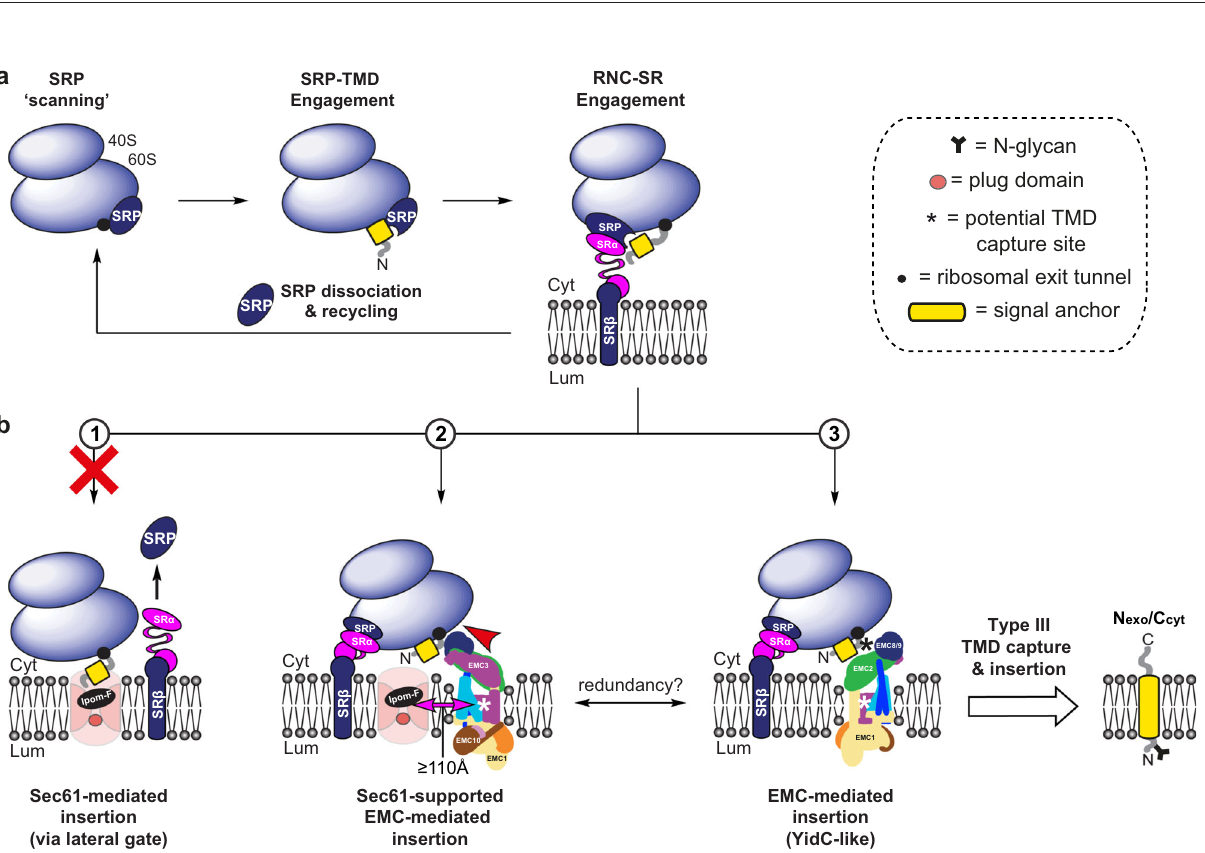
Fig. 6 Type III TMP insertion is dependent on the SRP receptor. a A model of SRP-dependent targeting to the ER membrane: the SRP ‘ scans ’ the emerging nascent chain of a translating ribosome for hydrophobic ER signal-sequences or transmembrane domains, binds the ribosome-nascent chain complex and delivers it to the ER membrane via its interaction with the SRP receptor, prior to membrane insertion 43 . The SRP receptor is a heterodimer comprised of the ER membrane-integrated beta subunit (SR β ) anchoring the peripherally associated cytosolic alpha subunit (SR α ). b The effect of transfecting HeLa cells with non-targeting (NT; lane 1), SR α -targeting (lane 2), SR α + EMC5-targeting (lane 3) and SR α + Sec61 α -targeting (lane 4) siRNAs was determined after semi-permeabilisation by quantitatively immunoblotting for: SR α , Sec61 α , EMC2, EMC5, EMC6, OST48 and LMNB1. c The ef fi ciency and statistical signi fi cance of siRNA-mediated single and double SR α knock-downs were calculated as a proportion of the signal intensity obtained with the NT control (set as 100%), and using LMNB1 as a loading control, as before (see Fig. 2). Other components tested were unaffected (see Supplementary Fig. 5). d OPG2-tagged control ( fi rst and second panels) and type III TMPs synthesised using SP cells pre-treated with the indicated siRNAs (NT, lane 1; SR α lane 2, SR α + EMC5, lane 3; SR α + Sec61 α -targeting, lane 4) were recovered and analysed as described in the legend to Fig. 3. e Relative membrane insertion ef fi ciencies were calculated using the ratio of N-glycosylated protein to non-glycosylated protein, relative to the NT control (set to 100% insertion ef fi ciency). To permit visual comparison across knock-down conditions, data are shown side by side with the membrane insertion ef fi ciency achieved in SP cells depleted of either Sec61 α and EMC5 subunits alone and in combination (these data are respectively from Figs. 3 – 5). Quanti fi cations are given as means ± SEM for three separate siRNA treatments ( n = 3, biologically independent experiments) and statistical signi fi cance (RM one-way ANOVA, DF and F values shown in the fi gure) was determined using Dunnett ’ s multiple comparisons test (versus two-way ANOVA in Figs. 3 – 5). Statistical signi fi cance is given as n.s., non-signi fi cant P > 0.1; * P < 0.05; ** P < 0.01; *** P < 0.001; **** P < 0.0001. N.B. When the data are re-analysed in this way, the effect of a single knock-down of Sec61 α on the membrane insertion of Cytb5 is now deemed statistically signi fi cant (cf. Fig. 3).